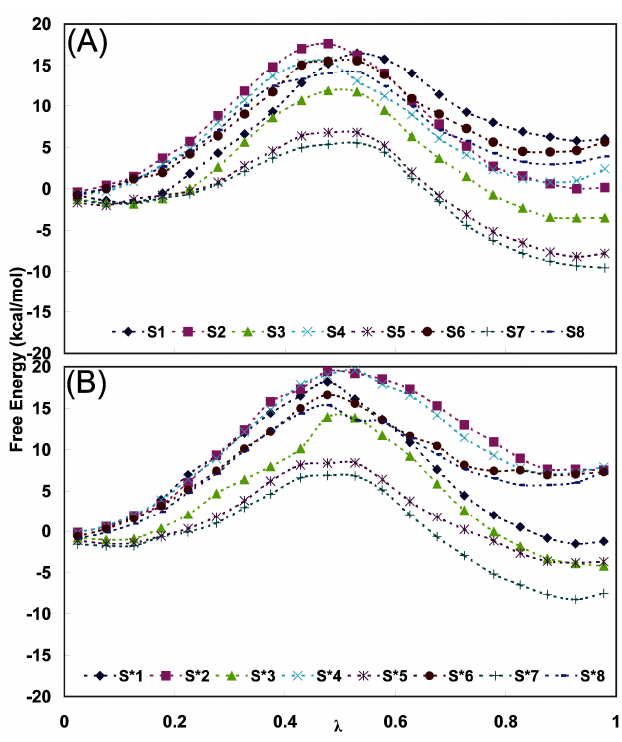
Figure 5. Average free energy variation with λ during the thermodynamic integration of 500 ps run in the case of (A) EPF charges and (B) Mulliken charges during (2 R ,4 S )F ↔ (2 S ,4 S )F conversions i. e. S and S* series simulations described in Table 3,